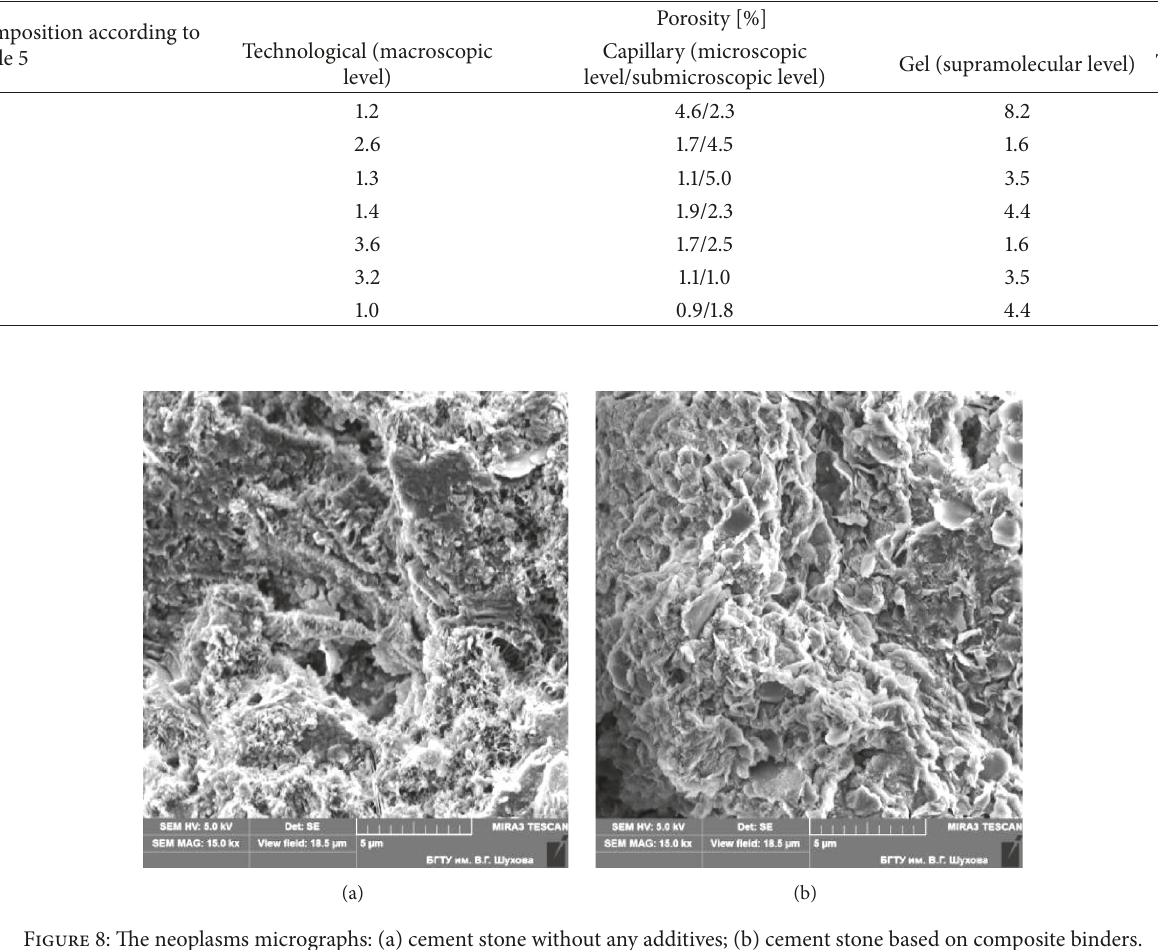
2 times (from 16.3% to 8%) should be noted. Fluctuations of different diameter pores which depend on nature of their formation should also be noted (Table